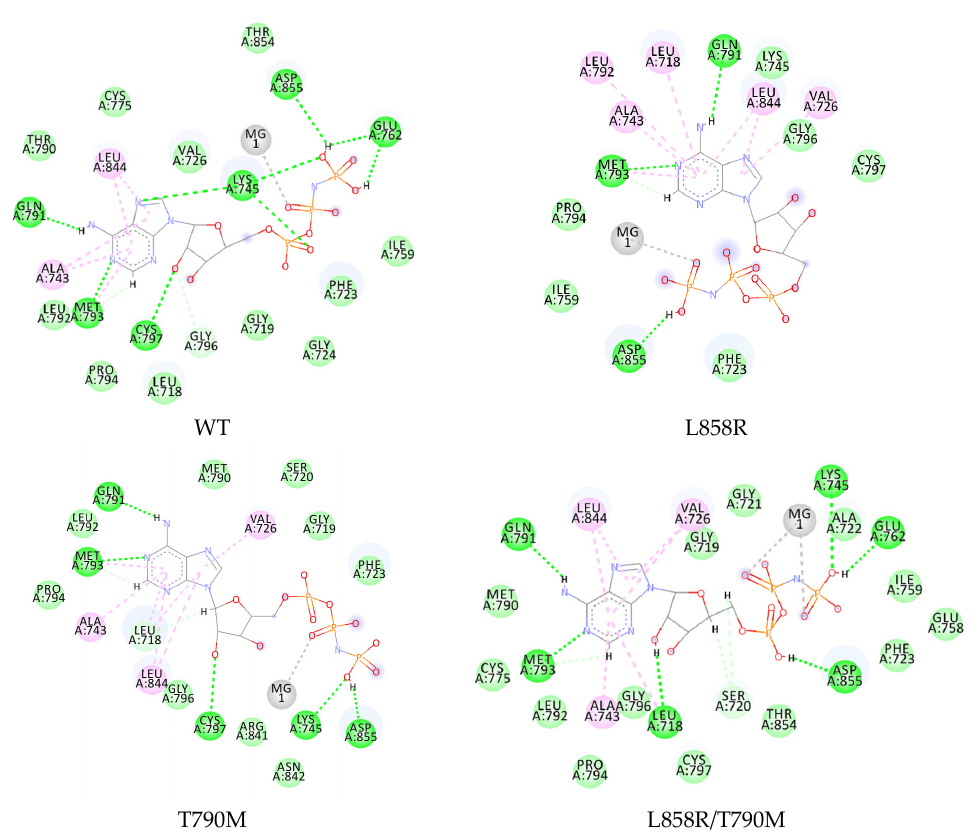
T790M L858R/T790M Figure 2. Two-dimensional interaction of ANP in the wild-type and mutated EGFR. Interactions are Figure 2. Two-dimensional interaction of ANP in the wild-type and mutated EGFR. Interactions are Figure 2. Two-dimensional interaction of ANP in the wild-type and mutated EGFR. Interactions are Figure 2. Two-dimensional interaction of ANP in the wild-type and mutated EGFR. Interactions are Figure 2. Two-dimensional interaction of ANP in the wild-type and mutated EGFR. Interactions are Figure 2. Two-dimensional interaction of ANP in the wild-type and mutated EGFR. Interactions are colored based on the type: , hydrogen bond; , van der Waals; , metal acceptor; , pi-alkyl. colored based on the type: , hydrogen bond; , van der Waals; , metal acceptor; , pi-alkyl. colored based on the type: , hydrogen bond; , van der Waals; , metal acceptor; , pi-alkyl. colored based on the type: , hydrogen bond; , van der Waals; , metal acceptor; , pi-alkyl. colored based on the type: , hydrogen bond; , van der Waals; , metal acceptor; , pi-alkyl. colored based on the type: , hydrogen bond; , van der Waals; , metal acceptor; , pi-alkyl. The binding energies were calculated by the MMPBSA method and are shown in Table